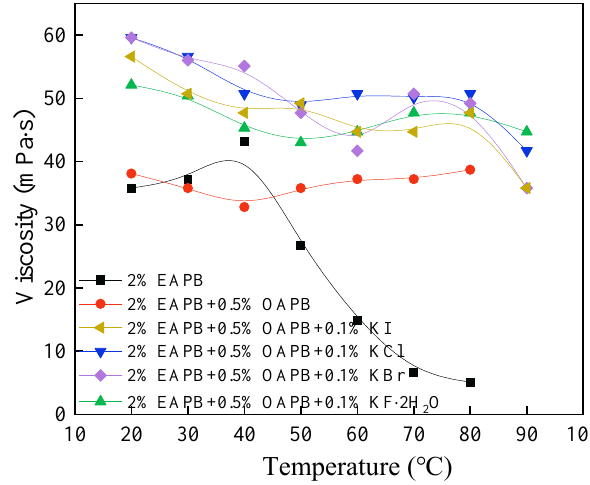
Figure 7. Effect of potassium salt on viscosity (100 r min −1 ).